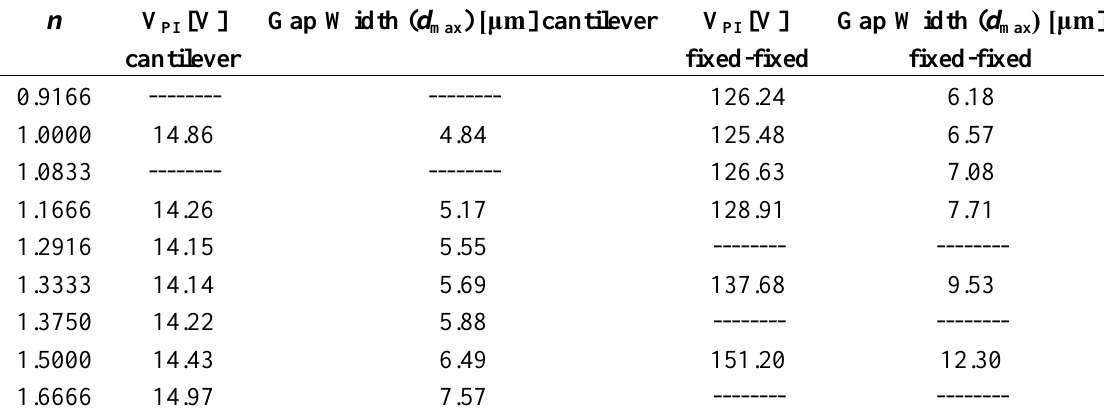
Table 7. Polynomial order and corresponding pull-in voltage for cantilever and fixed-fixed beams (required 2 μm displacement).